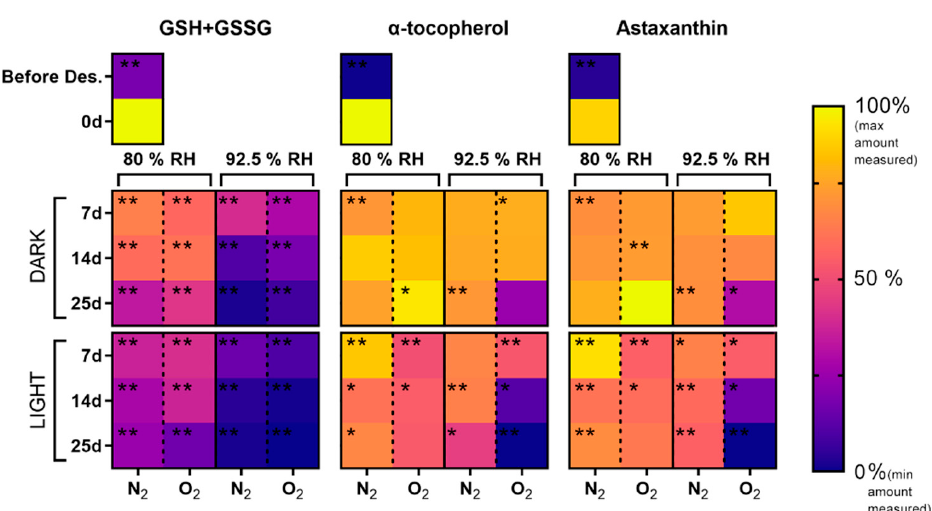
Figure 5. Interaction of oxygen, light and RH on changes in antioxidant and pigment concentrations in dehydrated cells. Data show relative differences on a false color scale (right side) of cells before desiccation (before Des.), immediately after desiccation (0 d), or after 7, 14 and 25 days (d) at 80.0% RH and 92.5% RH, under dark (upper panel) or light (lower panel), and in a high (O 2 ) or low (N 2 ) oxygen tension (below). Data have been normalized to dry weight and have shown relative to maximum values measured. Significant differences at p < 0.05 and p < 0.01 of absolute amounts between 0 d and all other time points are represented with * and **, respectively.